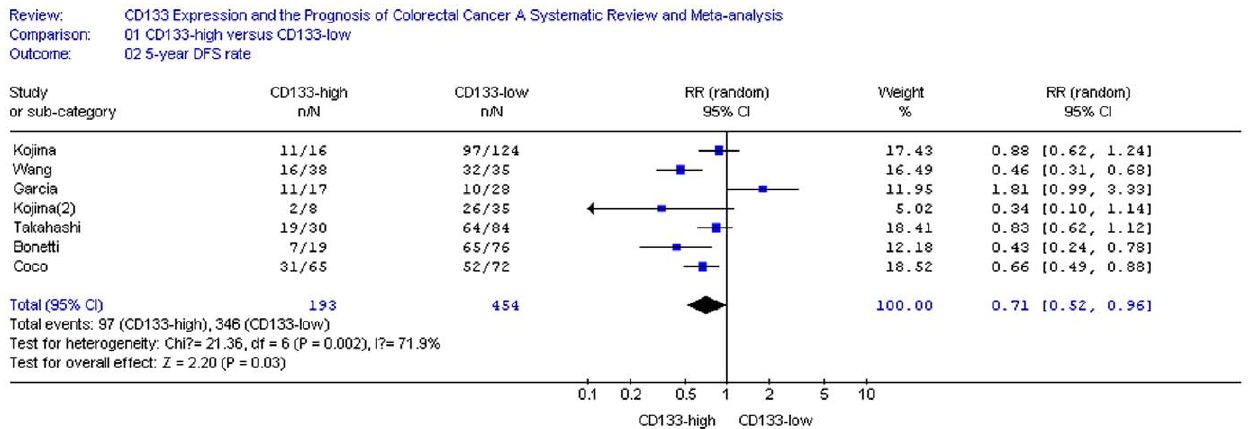
Figure 3. CD133 expression and 5-year DFS rate.